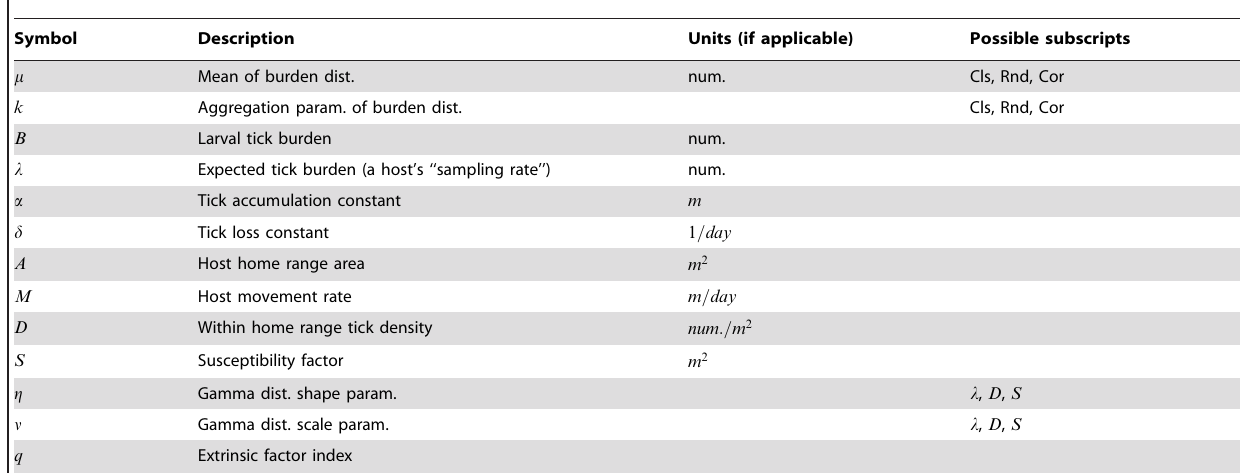
Table 1. A summary of the notation used in the paper.